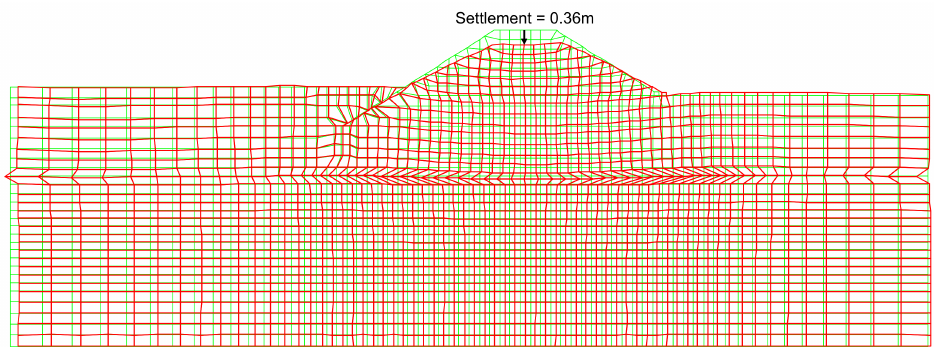
Figure 22. The numeral mesh before and after